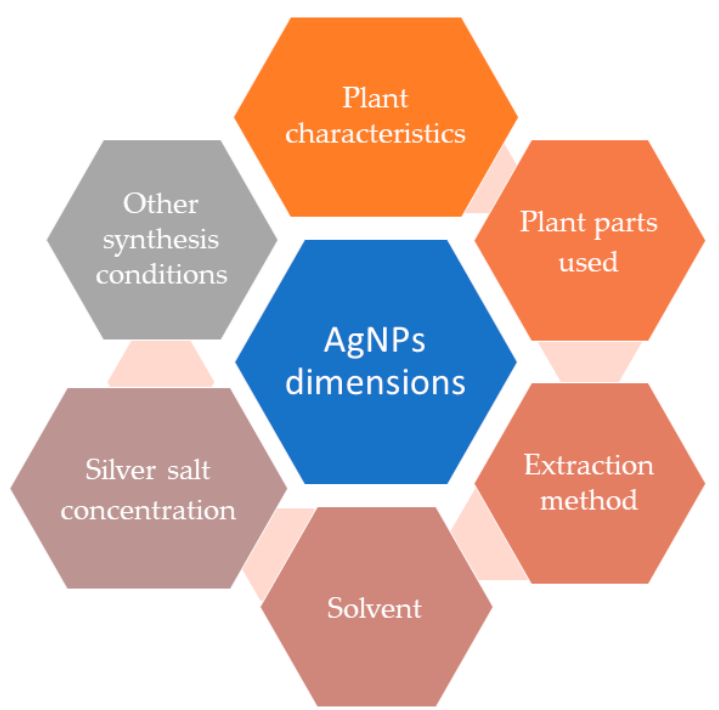
Figure 3. Factors influencing the morphological characteristics of silver nanoparticles and, consequently, their antimicrobial properties. their antimicrobial